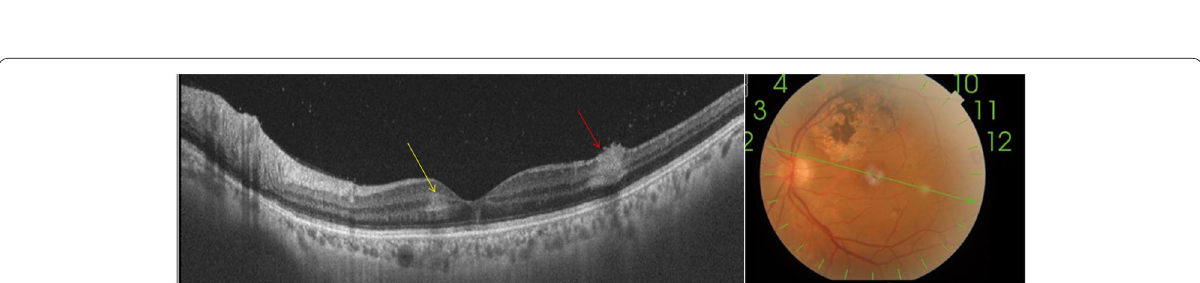
Fig. 2 Swept source OCT scan of the LE passing through a retinal infiltrate shows hyperreflective preretinal vitreous dots and a focal area of thickened, hyperreflective inner retina with infiltration extending from the nerve fiber layer to the outer retinal layers, with the ellipsoid zone, retinal pigment epithelium, and choroid clearly delineated and spared (red arrow). Note the presence of a band-like hyperreflective area in the middle retina suggestive of PAMM (yellow